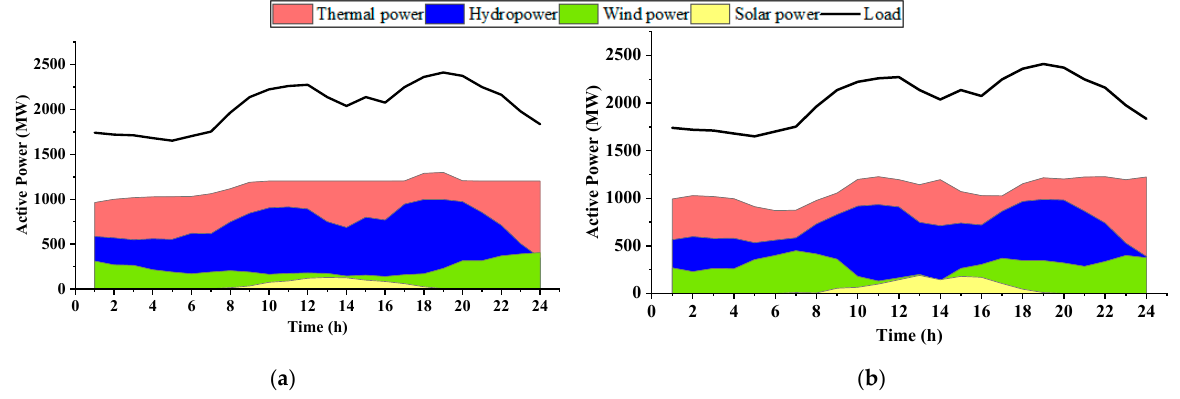
Figure 3. Output of various power plants. ( a ) Day-ahead scheduling; ( b ) output of real-time